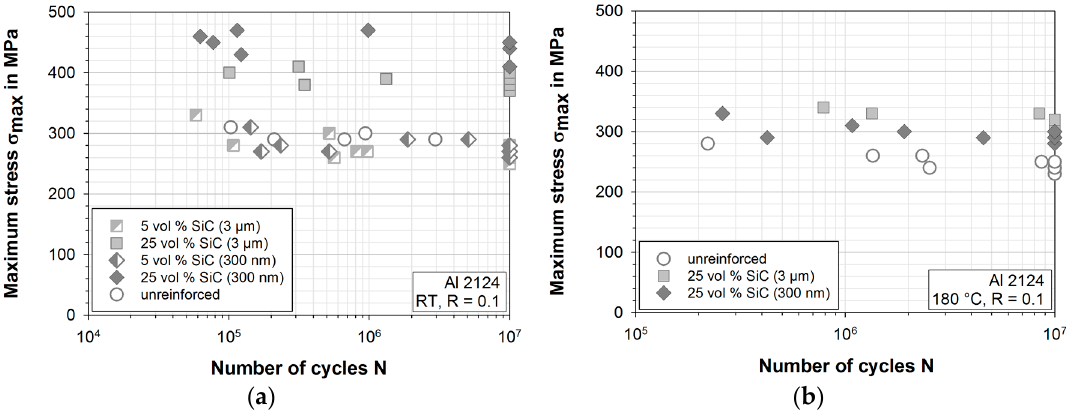
Figure 5. High cycle fatigue behavior of the unreinforced and reinforced 2124 aluminum alloy at R = 0.1 and ( a ) at room temperature and ( b ) at 180 °C. Table 3. Fatigue limit at N D = 10 7 cycles of the unreinforced and reinforced 2124 aluminum alloy at RT and load ratio R = 0.1.